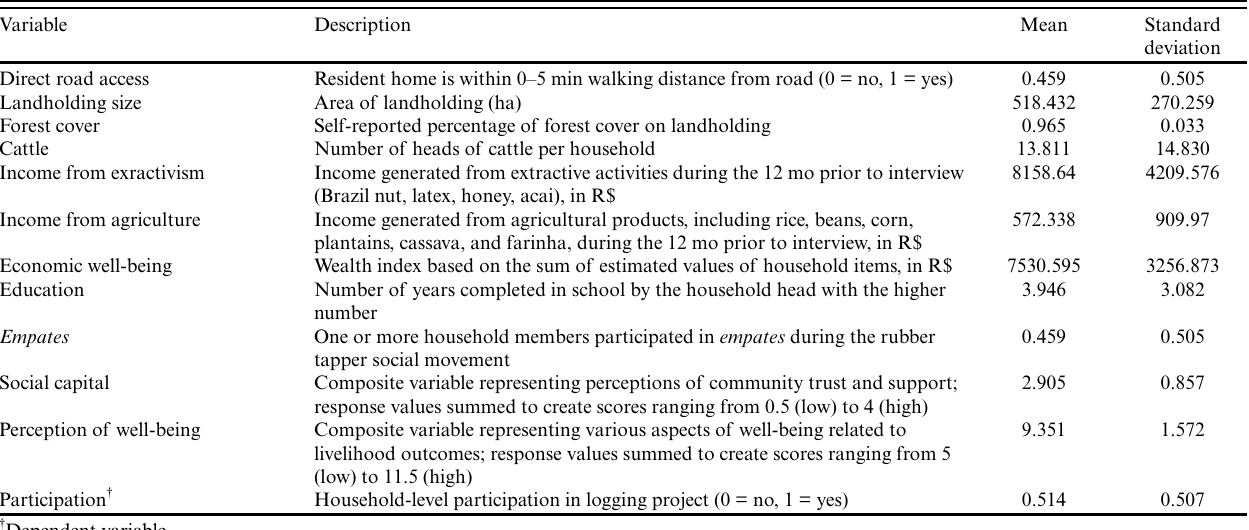
Table 1. Summary of household-level variables used in a logistic model describing residents of Chico Mendes Extractive Reserve, 2014. N =